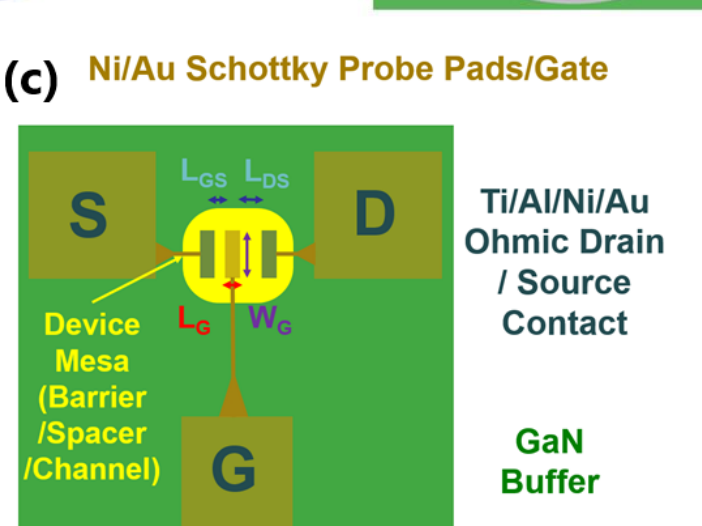
Figure 1. ( a ) A block diagram of the device structure. ( b ) A circular Schottky Barrier Diode pattern deposited only as Ohmic metal on the buffer. ( c ) A schematic configuration of the HEMT device.